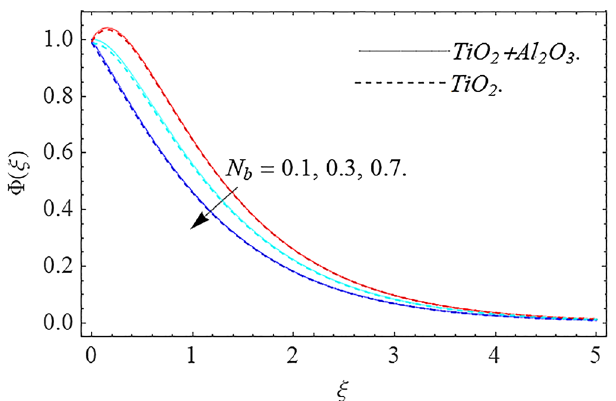
Figure 13. Concentration profile �(ξ) against N b .